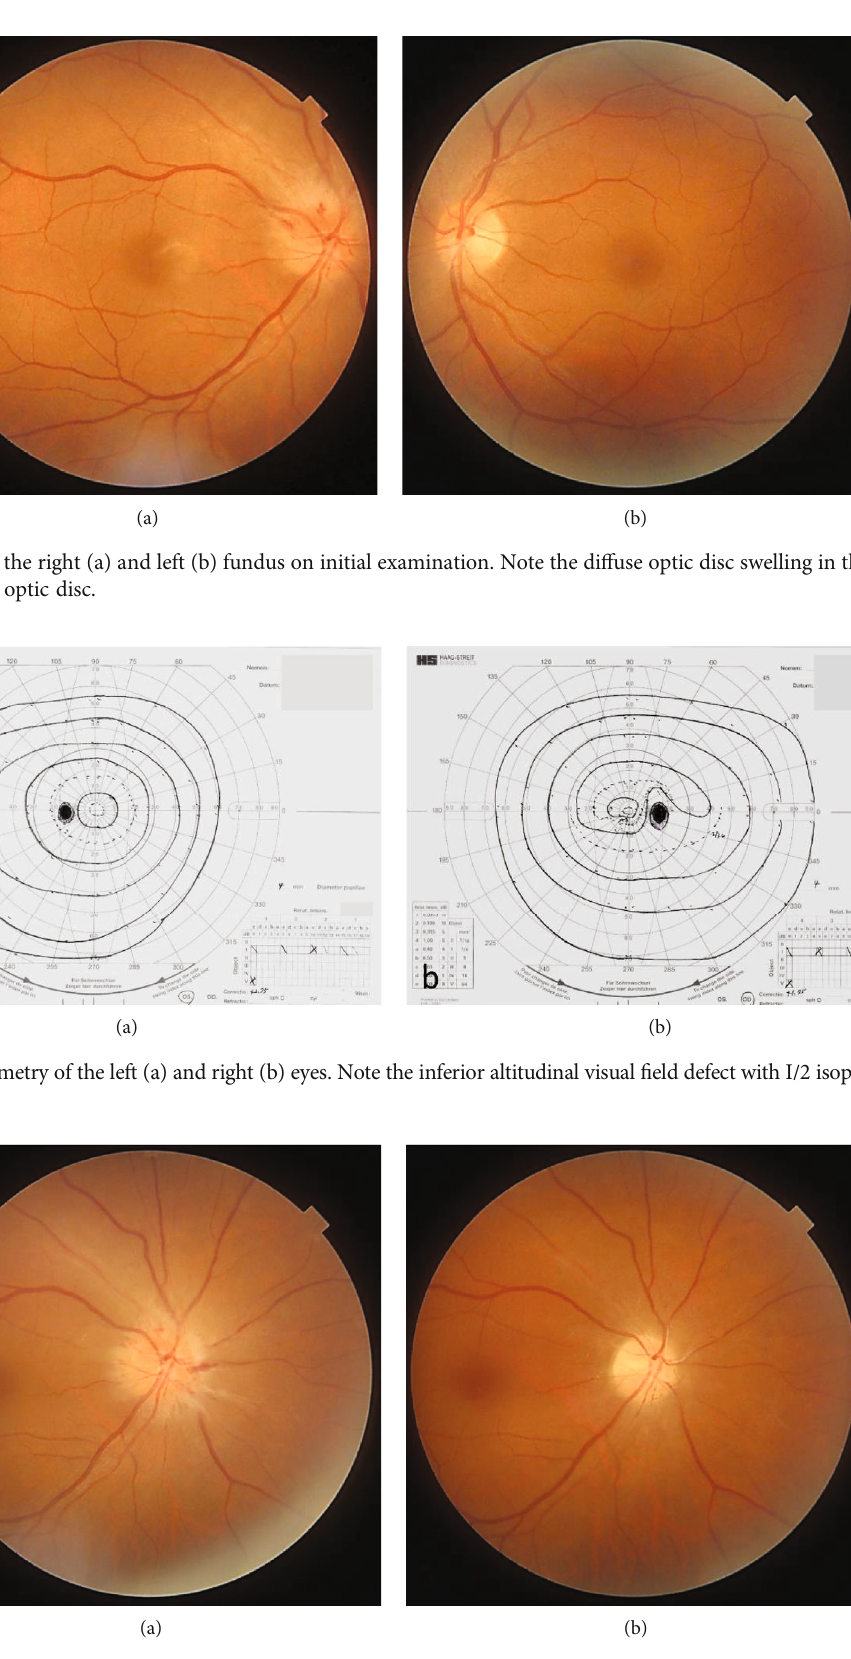
Figure 3: Photographs of the right fundus on 2 weeks (a) and 2 months (b) after the initial examination. Note the optic disc swelling was gradually improved; however, the optic disc looked di ff usely